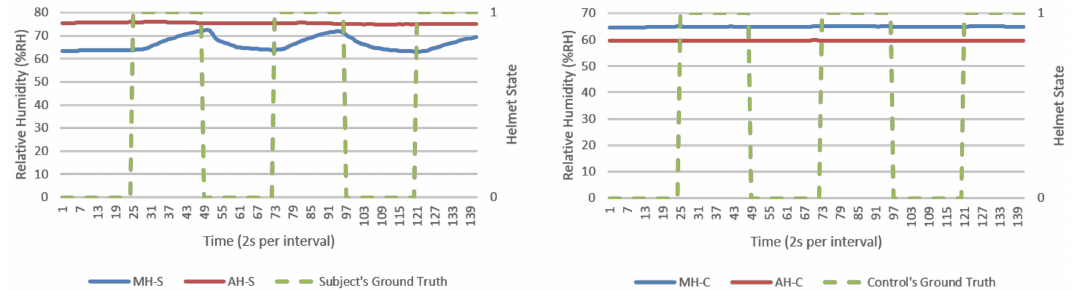
Figure 8. Relative humidity (%RH) versus time (2 s per interval) data logs from a typical M run, human subject ( left ), and experiment control ( right ). Helmet state 0 = NW and 1 =